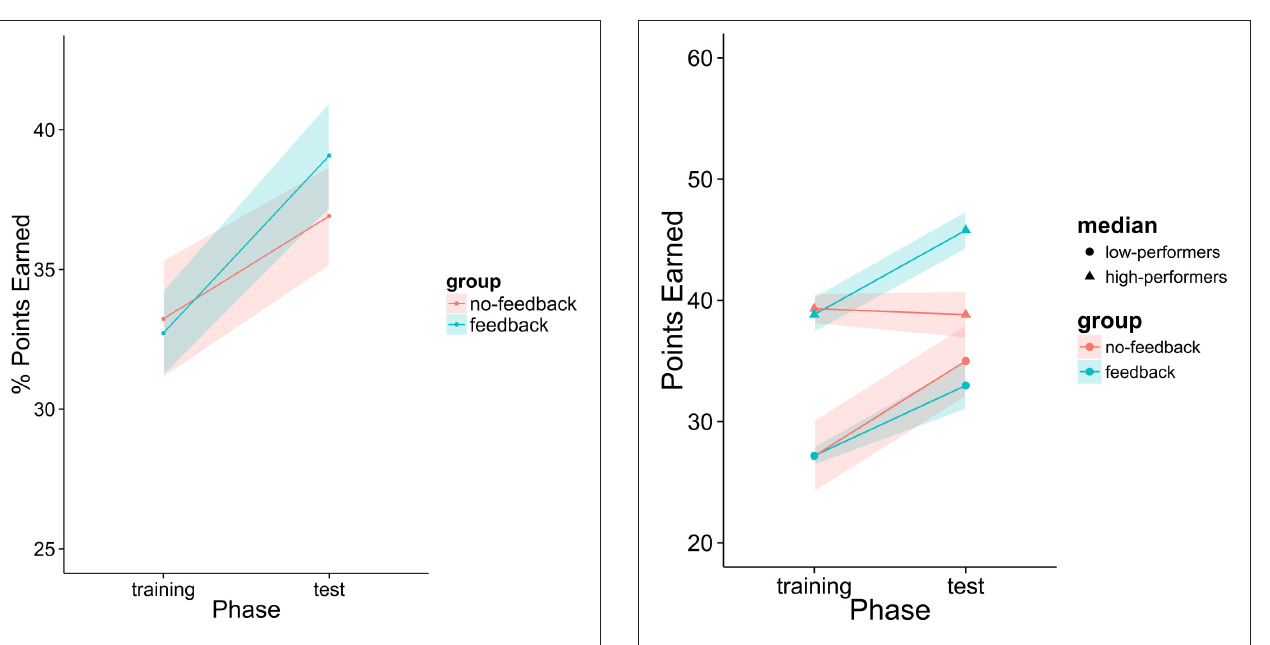
FIGURE 12 | Percentage of points earned by the player as a function of group and experiment phase. Fifty percent represents an even split between the human player and the model.